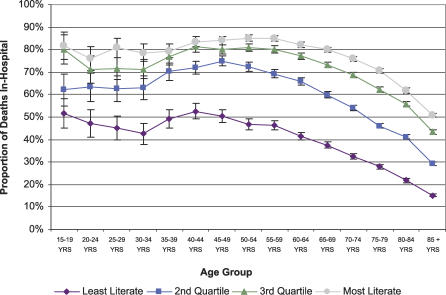
Proportion of Cerebrovascular Disease Deaths That Were in Hospitals, versus Age Group, According to Community Literacy Quartiles, Mexico 1998–2005Data are means and 95% confidence intervals.